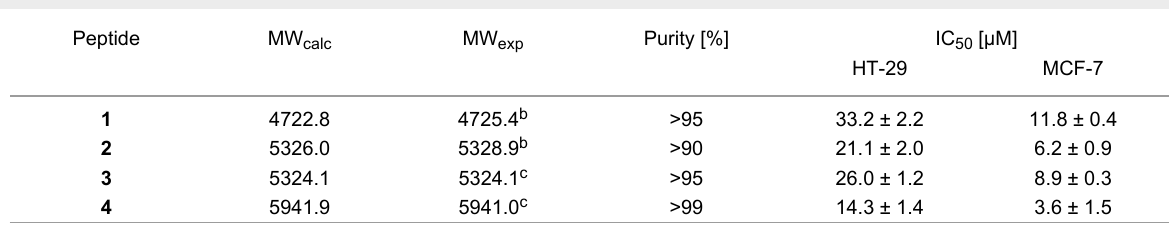
Table 2: Analytical data and IC 50 values of the (sC18) 2 bioconjugates. a